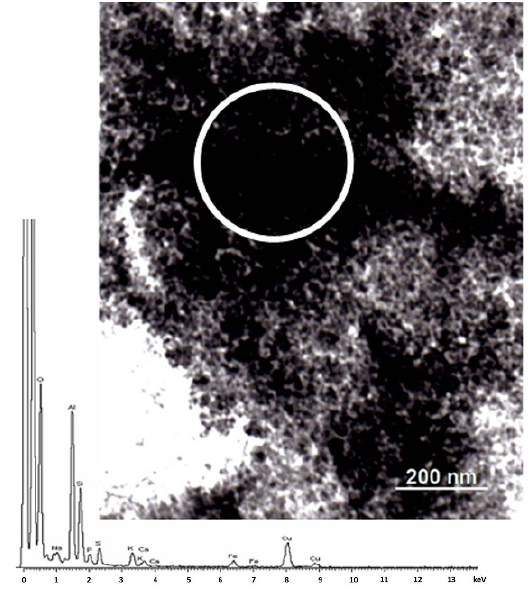
Figure 3. TEM micrograph of a dust sample from Gdansk (collected on 16.06.2006) and EDX